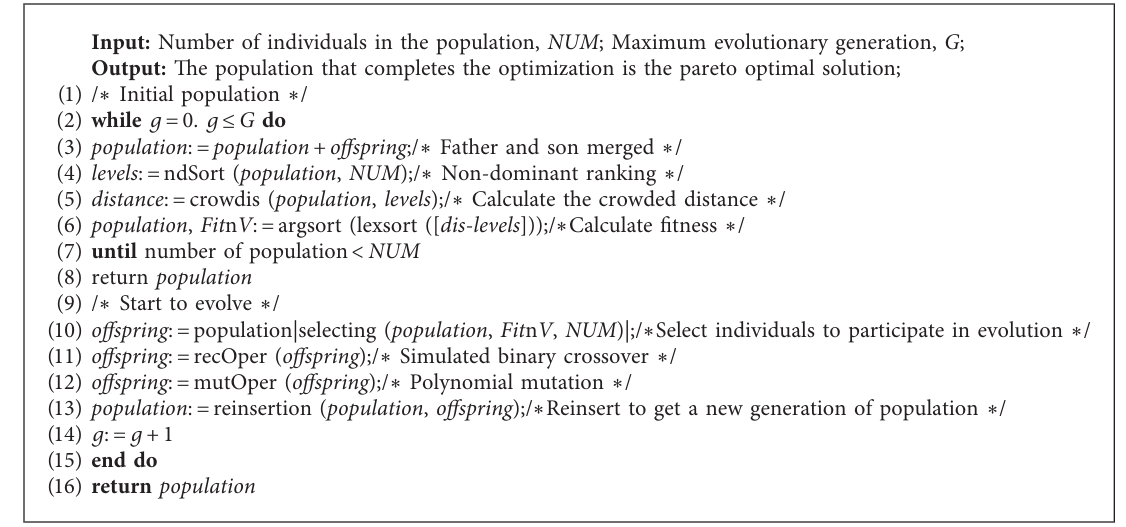
A LGORITHM 1: NSGA-II